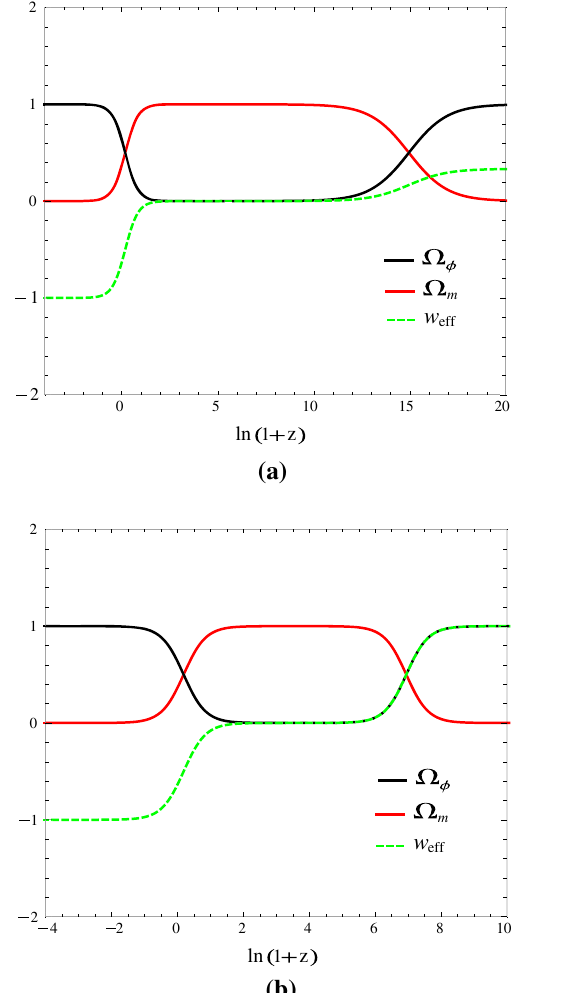
Fig. 3 The time evolution of the relative matter energy density Ω m , the relative scalar field energy density Ω φ and the effective EoS w eff . Here we take f (φ) = f 0 e βφ , β = 5 and V = constant, w = 0 with α = 2 in a and α = 1 in b